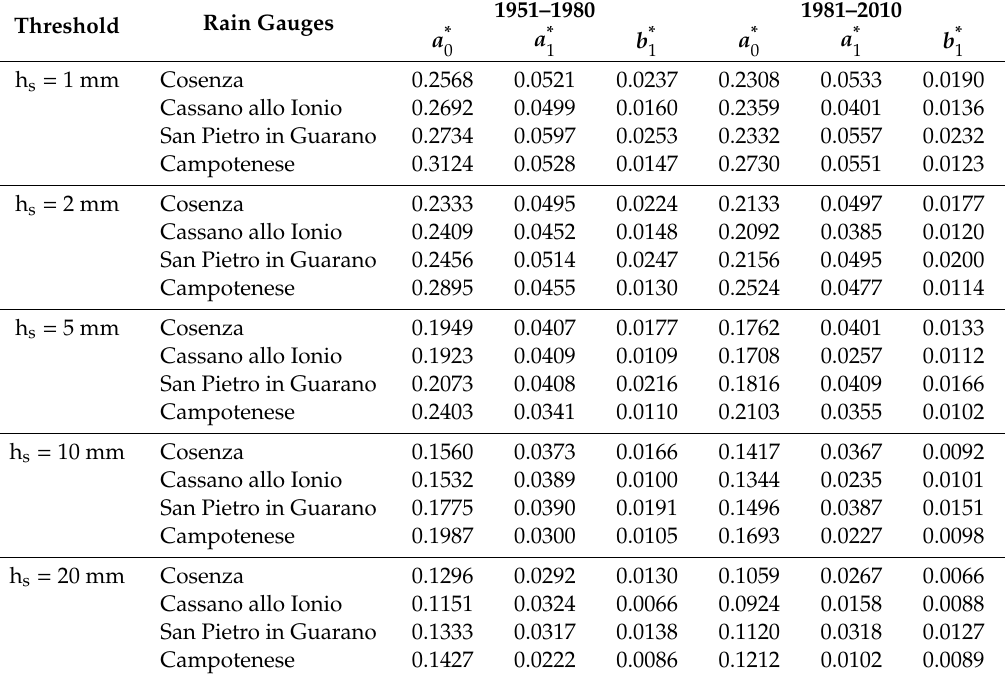
Table 2. Estimated values of the Fourier coe ffi cients for di ff erent 30-year periods and thresholds. Threshold Rain